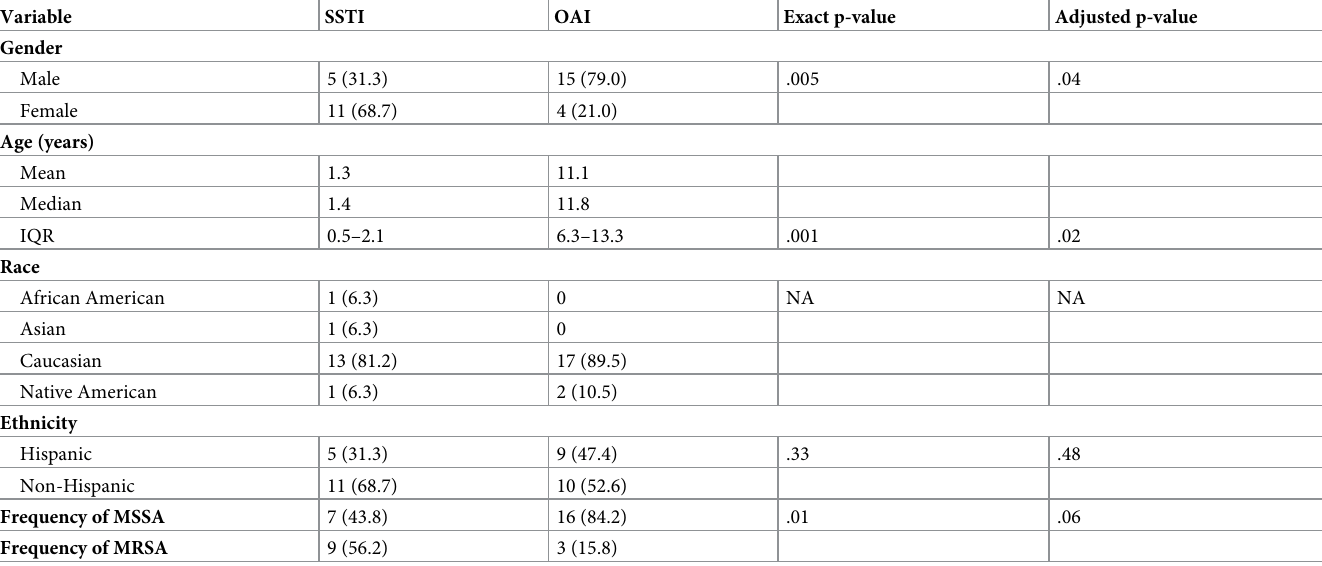
Table 1. Demographic, clinical and microbiological overview of 35 children with osteoarticular infections and skin and soft tissue